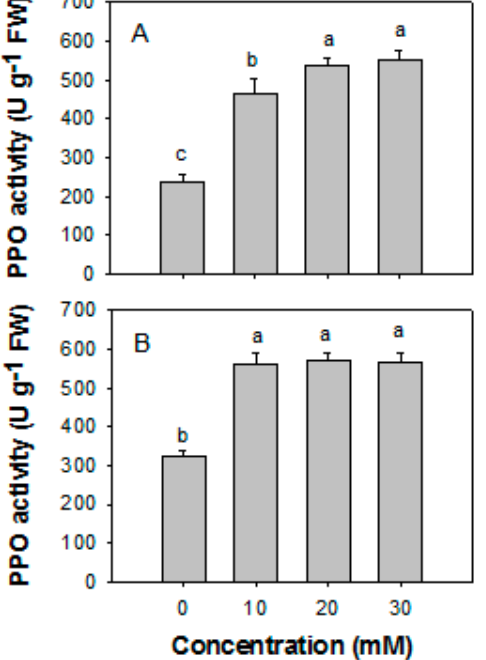
Figure 4. Effects of H 2 O 2 at various concentrations on the activities of PPO ( A ) and POD ( B ) of papaya fruit inoculated with Colletotrichum gloeosporioides after 10 days of storage at 25 °C. The papaya fruit were immediately inoculated with C. gloeosporioides after H 2 O 2 treatment and dried. The pericarp tissue of papaya fruit was sampled at 0–1 cm from the lesions. POD, peroxidase; PPO, polyphenol oxidase. The data were expressed as the means ± SE of three biological replicates. Different letters indicate significant differences.